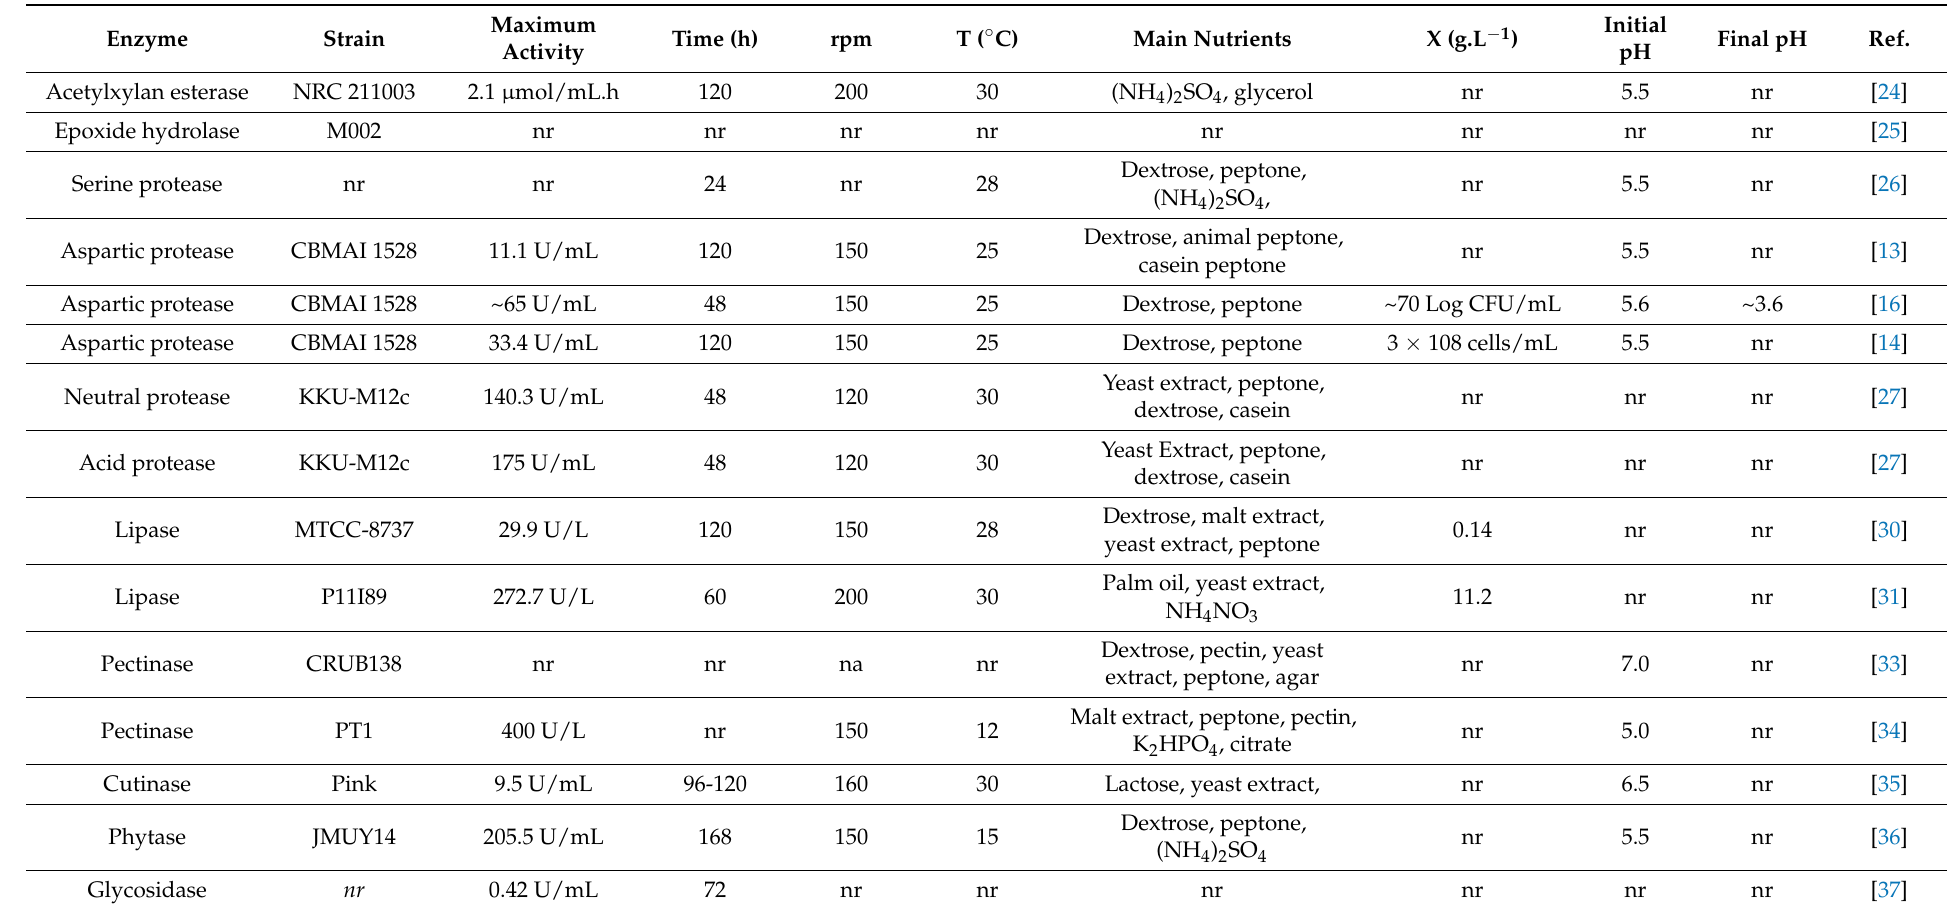
Table 5. Enzyme production by Rhodotorula mucilaginosa strains in agar plate or rotatory